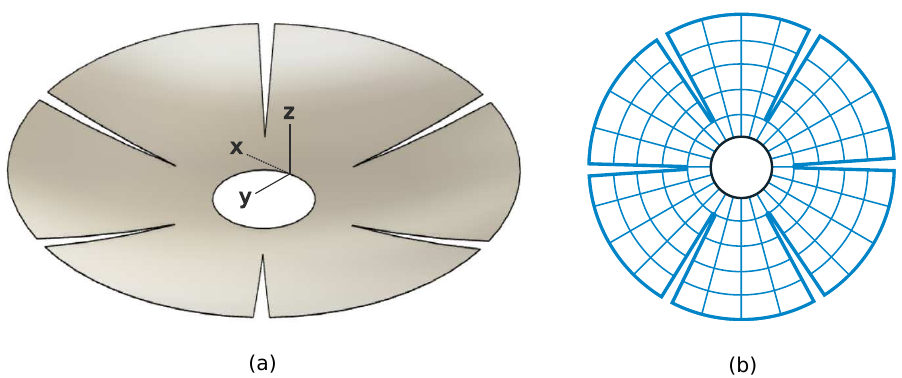
Figure 9. ( a ) Geometry of the petal reflector (the boundary conditions are the same as in Figure 6). ( b ) Layout of the 120